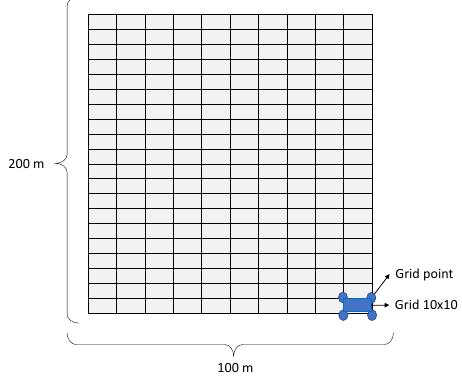
Figure 11. Dividing the area into smaller rectangles for